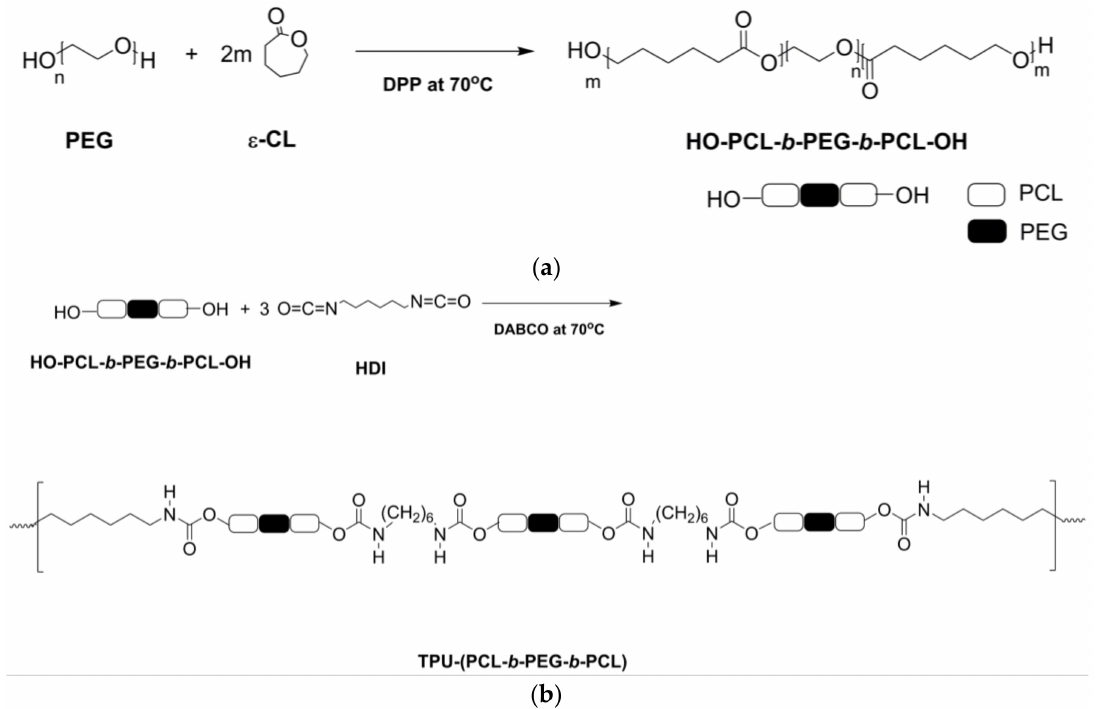
Figure 1. Synthesis of ( a ) hydroxyl-group terminated HO-PCL- b -PEG- b -PCL-OH triblock